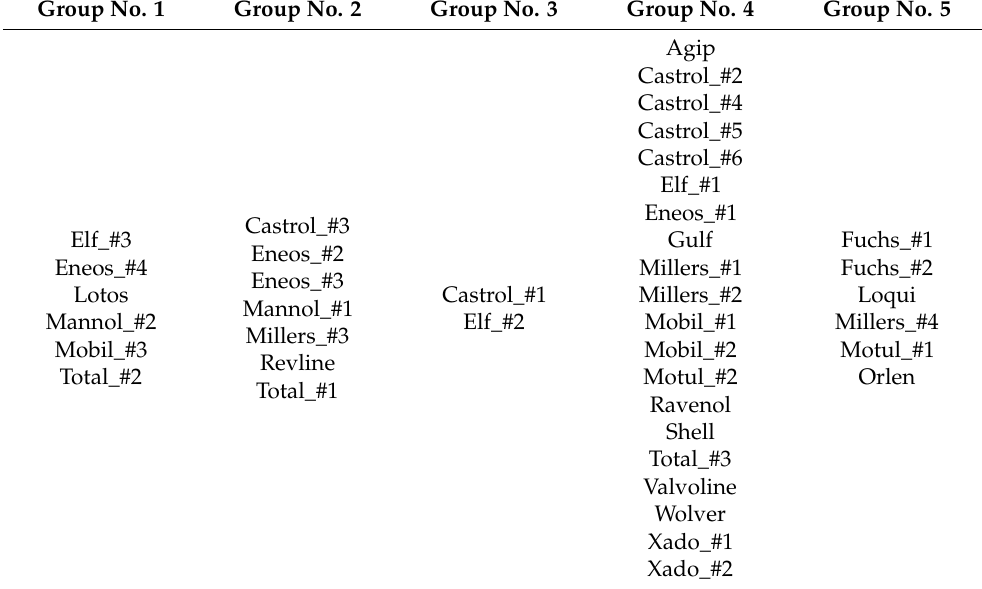
Table 6. Assignment of the oils into the different groupings according to similarity in conductance values. Group No.